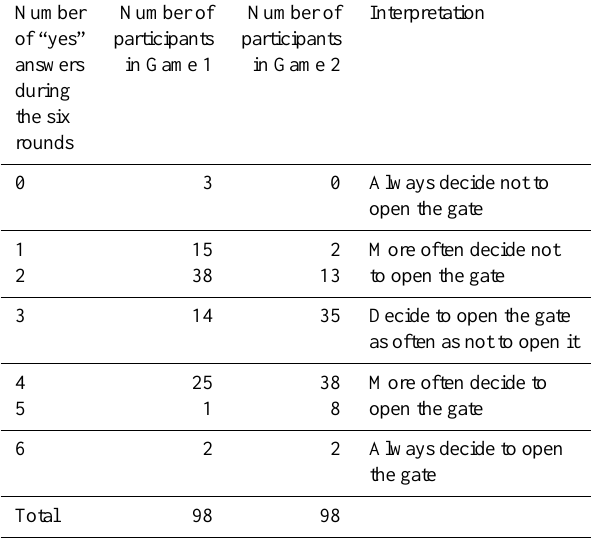
Table 2. Number of participants in Game 1 and Game 2 according to the number of “yes” answers (i.e. number of decisions to open the gate) during the six